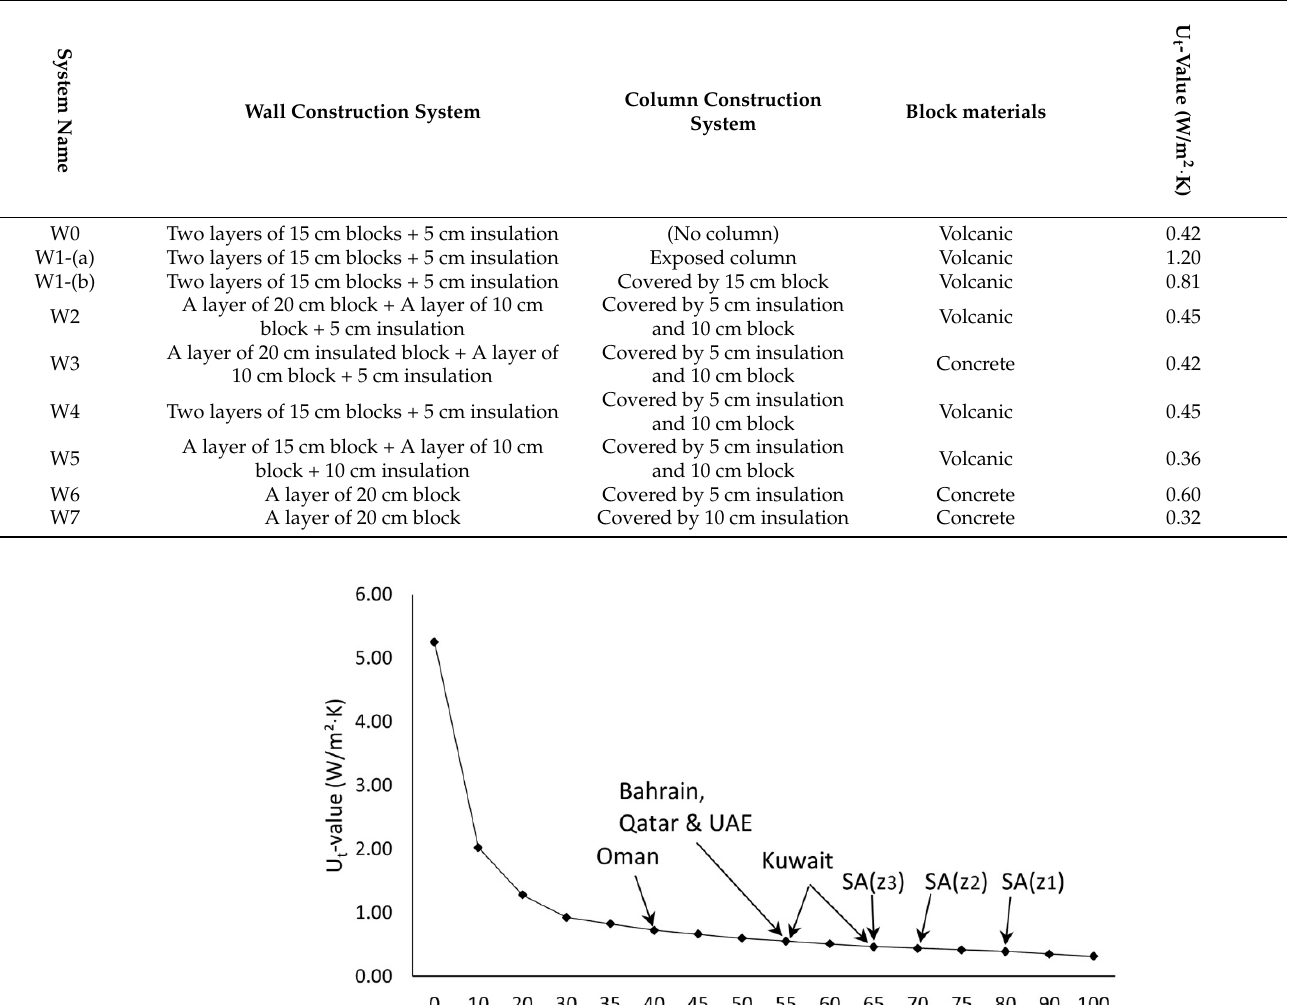
Table 8. Wall system specifications and the effective U t -values of the different wall systems.